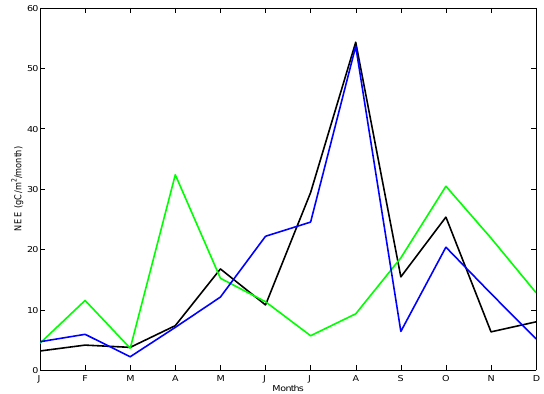
Figure 8. Yearly trend of the cumulative weekly NEE averaged over 2001–2004 for the observations (black curve), for the model run with the a priori parameter set (green curve) and with the 2001– 2004 inverted parameter set ( X 4 Y , blue curve).